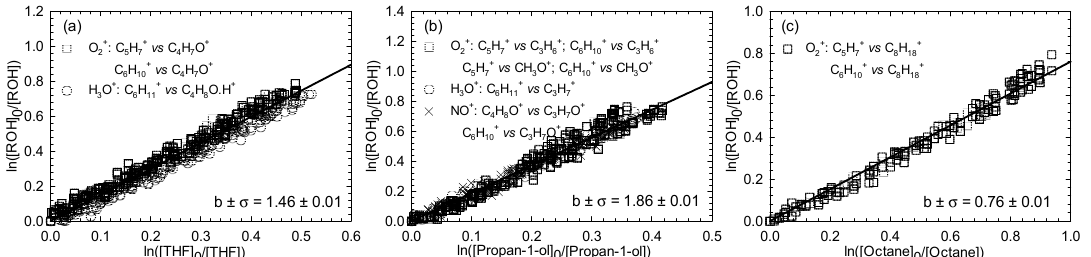
Figure 3. Relative loss of ( E )-3-hexen-1-ol vs. that of THF ( a ), propan-1-ol ( b ), and octane ( c ) in the Cl atom-initiated reaction.